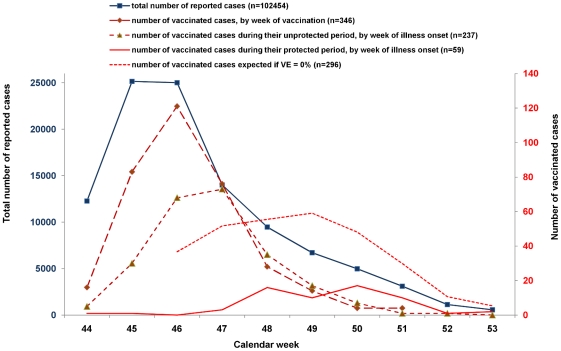
Case-series method.Frequency of total number of cases with known age and onset of illness (grey, left y-axis), of vaccinated cases by week of vaccination (dashed grey line; right y-axis), vaccinated cases by week of illness onset (unprotected period; dashed-dotted line; right y-axis), vaccinated cases by week of illness onset (protected period; black line; right y-axis) and vaccinated cases by week of illness onset that would be expected if the vaccine had no effect (protected period; dashed black line; right y-axis), Germany; week 44–53, 2009.